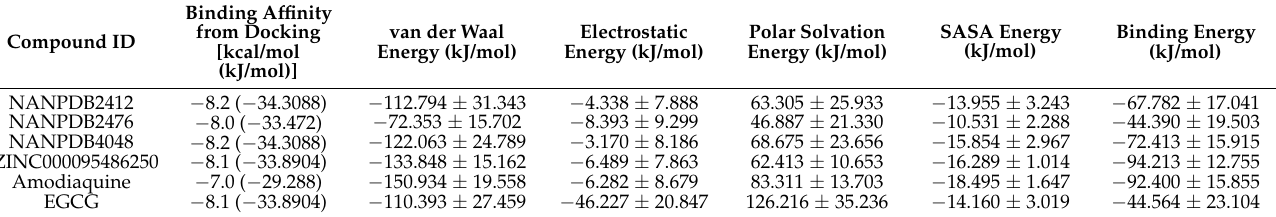
Table 7. The free energy terms for the binding of compounds to the EBOV VP35 protein. The energy values are presented as average ± standard deviations in kJ/mol. The binding affinity scores from the docking studies are represented as “kcal/mol (kJ/mol)”, where the calculated binding affinity in kJ/mol are presented in brackets. Binding Affinity from Docking van der Waal Electrostatic Compound ID [kcal/mol Energy (kJ/mol) Energy (kJ/mol) (kJ/mol)]